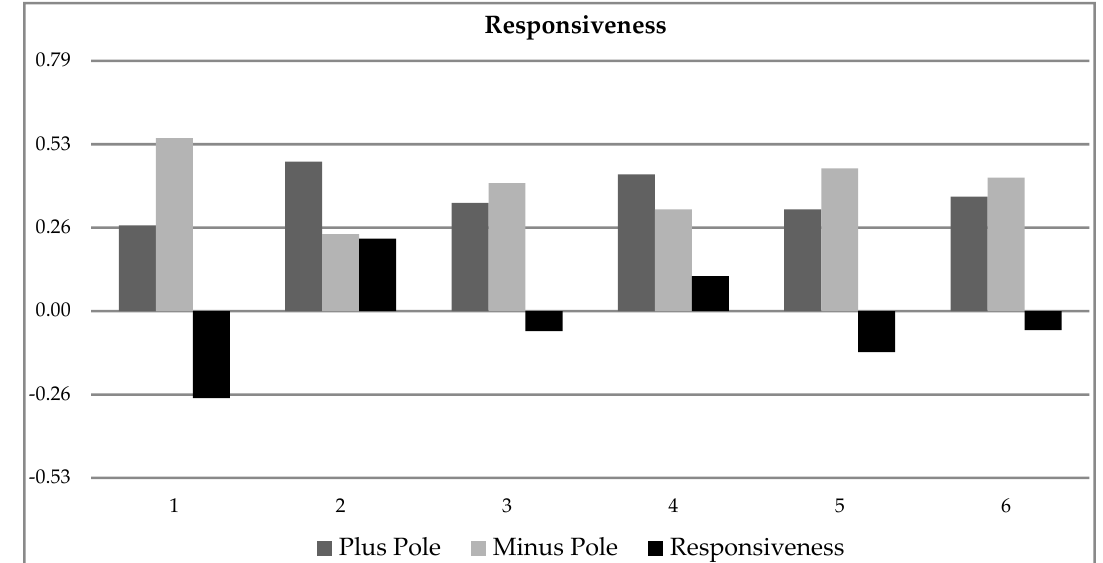
Figure 3. Example of trait Responsiveness for the first six subjects.